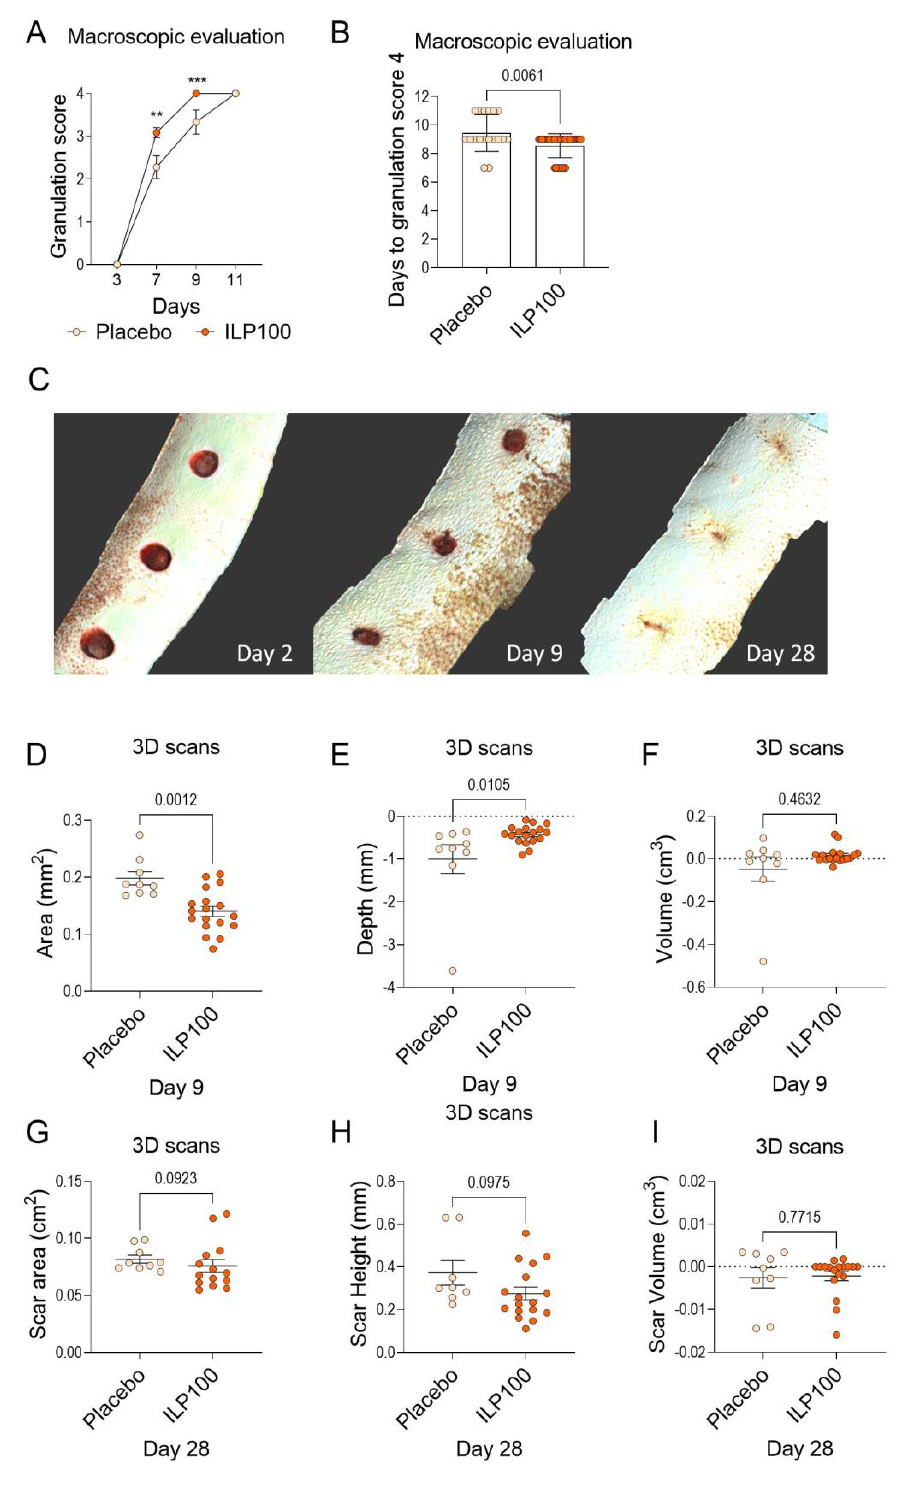
Figure 4. Wound healing assessed by macroscopic evaluation and from 3D scans in Cohort B. Wounds in Cohort B were macroscopically evaluated for granulation tissue formation by granula-